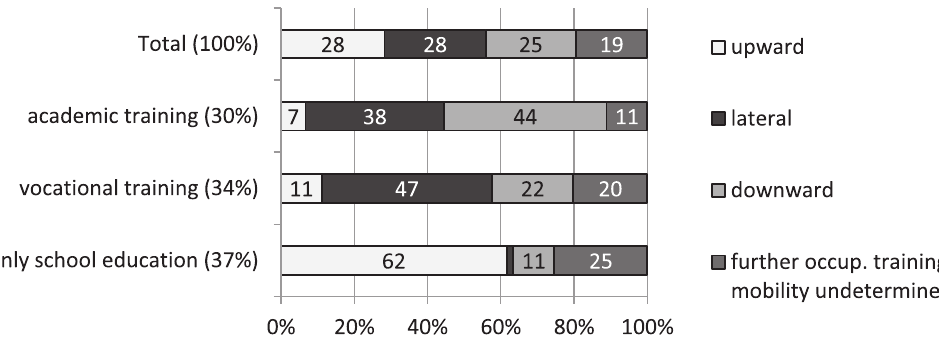
Figure 1. Vertical direction of transnational educational mobility by pre-migration level of education. Source: NEPS (2020). Notes: authors’ calculation; N = 313; weighted